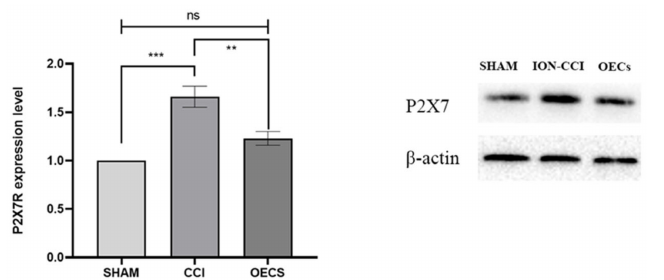
Figure 4. Changes in P2X7R protein level in TG. We used Image J to analyze the gray value of the WB results, and compared the expression of P2X7R through β -actin. The P2X7R expression was significantly higher in the ION-CCI group than in the sham group ( p < 0.05). However, it was significantly lower in the OEC group than in the ION-CCI group ( p < 0.05), and slightly higher in the OEC group than in the sham group ( p > 0.05). Data are expressed as mean ± SEM ( n = 4 per group, one-way analysis of variance followed by the least significant difference post hoc test). *** Indicates p < 0.001 when comparing the sham and ION-CCI groups, ** indicates p < 0.01 when comparing the ION-CCI and OEC groups, and Ns. means p > 0.05 when comparing the sham and OEC groups. The OEC group was comprised of rats with ION-CCI that were treated with OECs. ION-CCI, chronic constrictive injury of infraorbital nerve; OEC, olfactory ensheathing cell; SEM, standard error of the mean; TG, trigeminal ganglion.